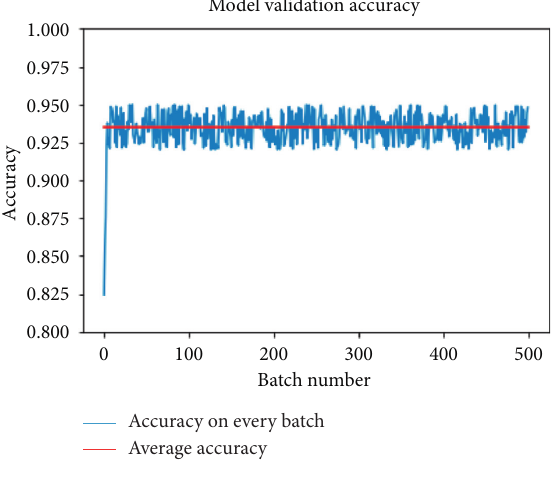
Figure 19: Validation